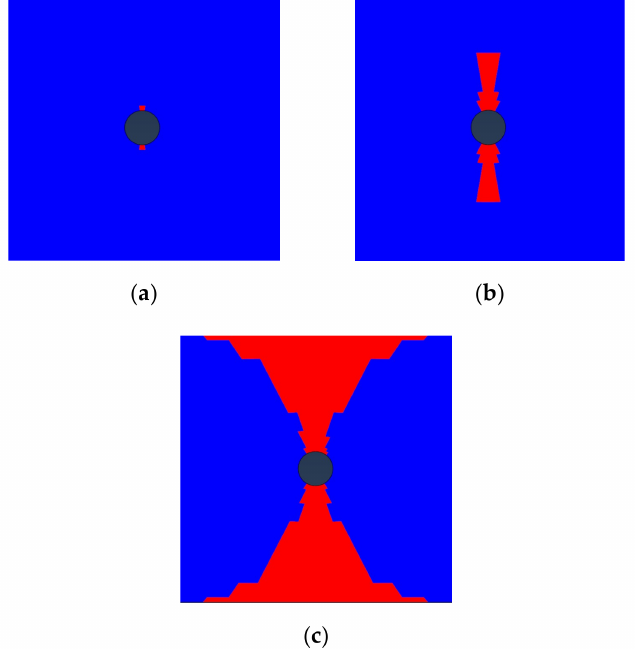
Figure 11. Fiber damage and failure paths in 0 ◦ layer of laminated plates using the GMC/Tsai–Hill method ( a ) initial damage; ( b ) damage at 90 percent failure; ( c ) damage at final